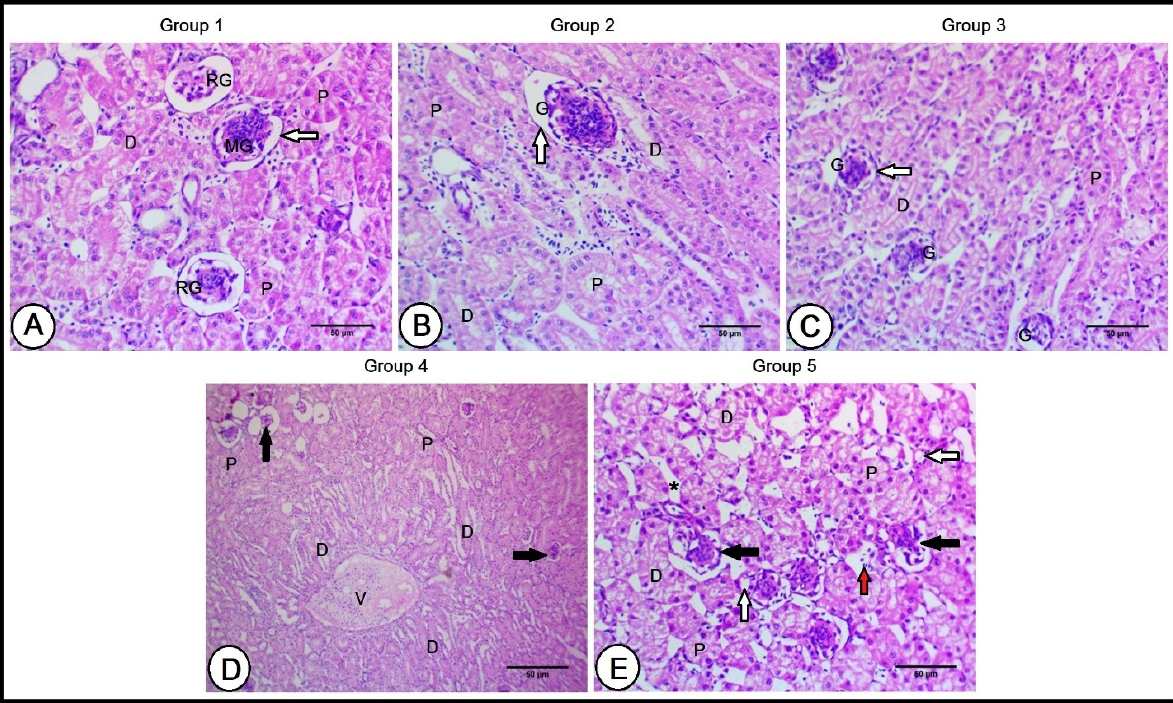
Figure 2. A histopathological analysis of the renal cortex in the experimental groups ( A ): Renal cortex of the control group showing glomeruli of reptilian-type nephrons (RG) and glomeruli of mammalian nephrons (MG), and proximal (P) and distal (D) convoluted tubules. The glomerulus was surrounded by thin glomerular basement membranes (black arrow). The renal cortex of the second ( B ) and third ( C ) groups revealed large-sized proximal (P) and distal (D) convoluted tubules. The glomeruli (G) increased in size in the second group; however, their size was slightly reduced in the third group. The glomeruli were surrounded by thin glomerular basement membranes. The renal cortex of the fourth group ( D ) shows small-sized glomeruli (black arrows) and a concentric arrangement of distal convoluted tubules ( D ) around the intralobular vein (V). The renal cortex of the fifth group ( E ), illustrating small-sized glomeruli, surrounded by irregularly disrupted basement membranes (black arrows), and large interstitial spaces (black asterisk) between small-sized proximal (P) and distal (D) convoluted tubules. Note the presence of atrophied tubules (white arrows) and few lymphocytic infiltrations (red